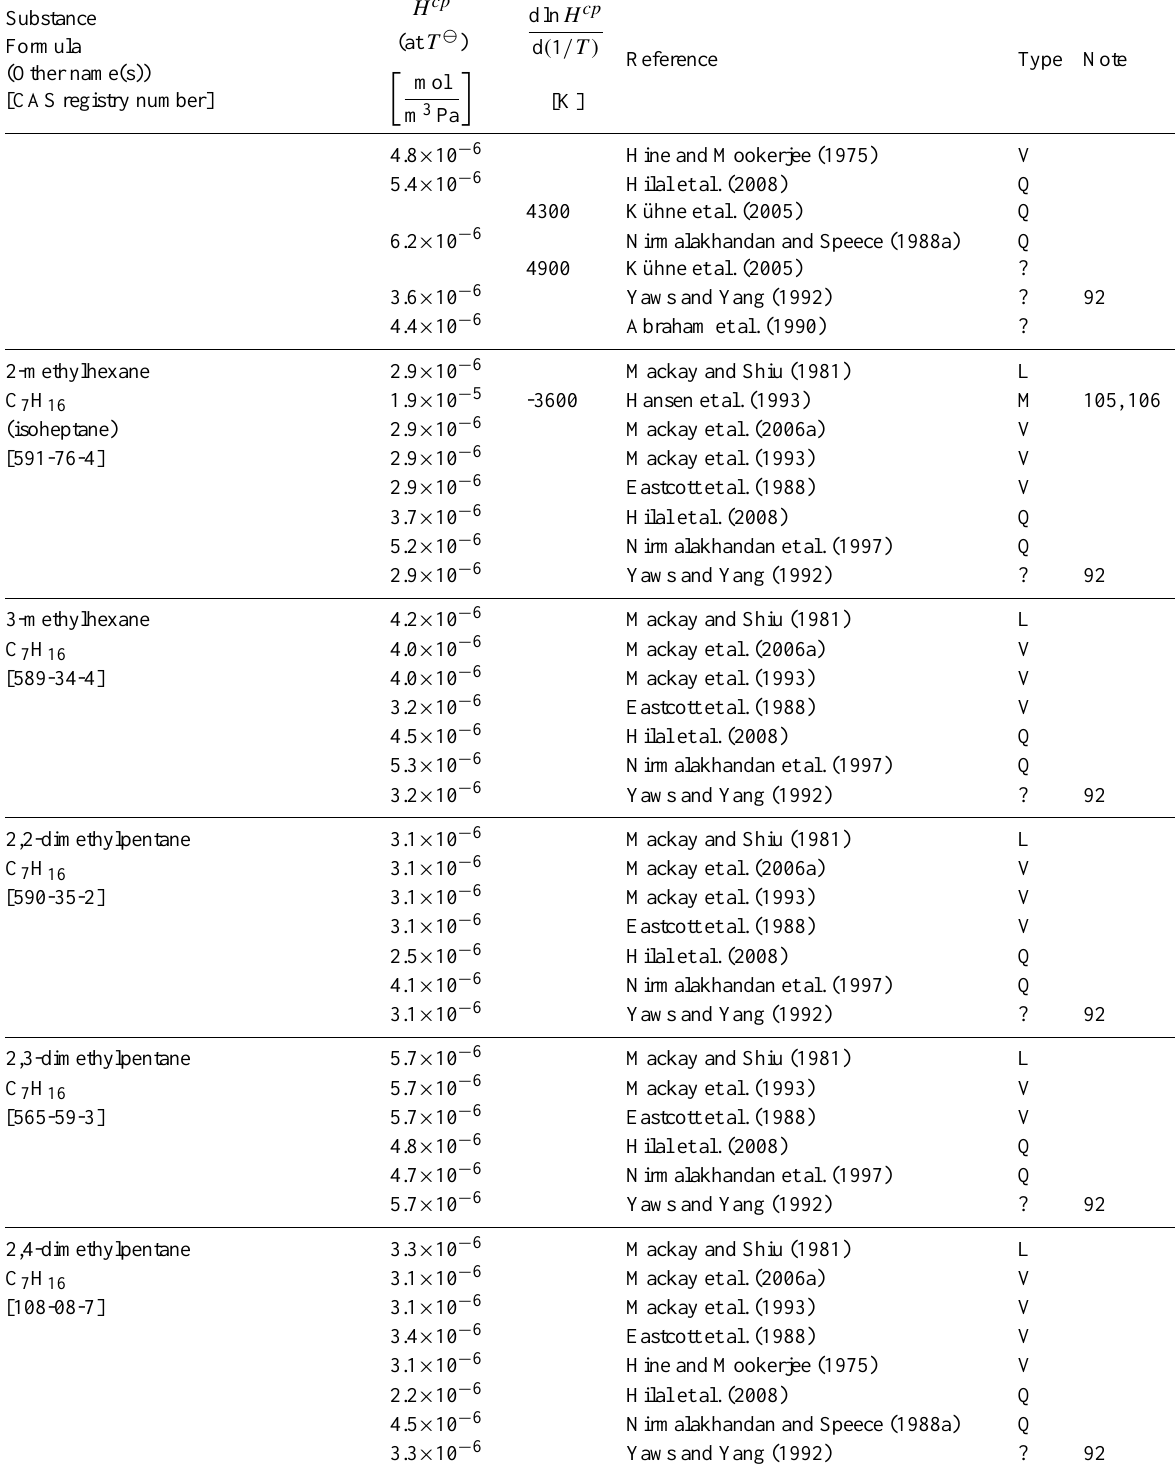
Table 6: Henry’s law constants for water as solvent